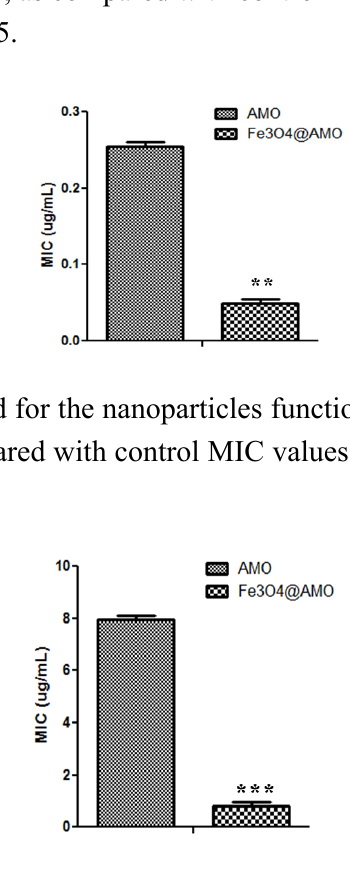
O @AMO on S. aureus adherence at the inert substrata after 3 4